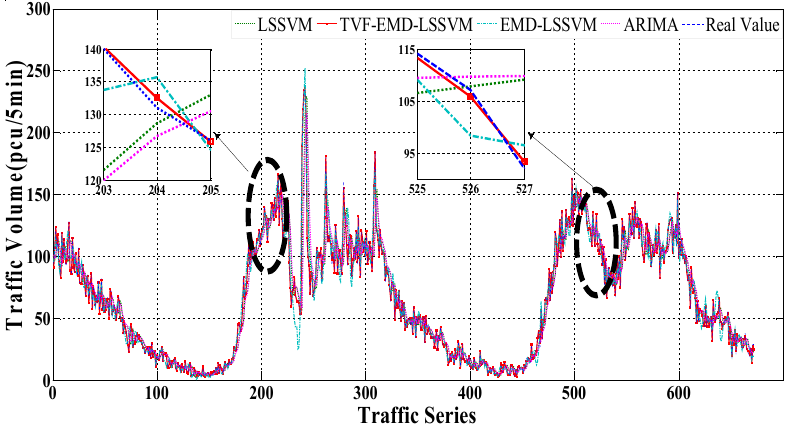
Figure 6. Traffic volume time series (B) . Table 3. Data characteristics (B).